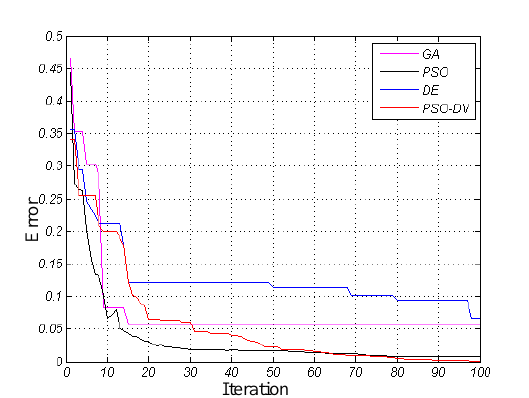
Figure.17. Error rate for GA, PSO, DE and PSO-DV (frame 2).